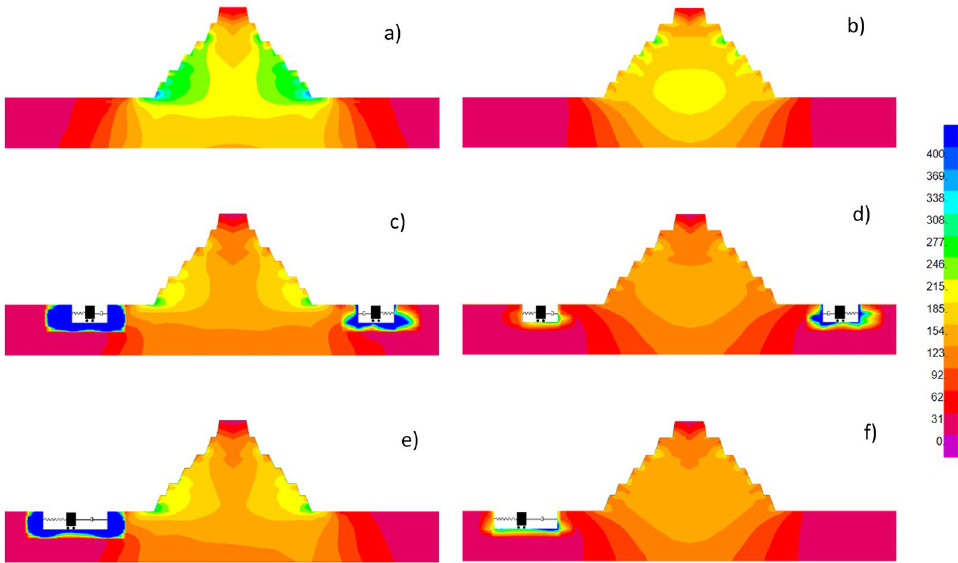
Figure 6. Von Mises stress distribution at t = 2.69 s for a randomly selected simulated ground motion; Panels ( a ) and ( b ) display the Zoser pyramid without ViBa cross section in N–S and E–W direction; Panels ( c ) and ( d ) show the ViBa effect on the stress distribution for Case 1; ( e ) and ( f ) effect of the ViBa on the stress distribution for Case